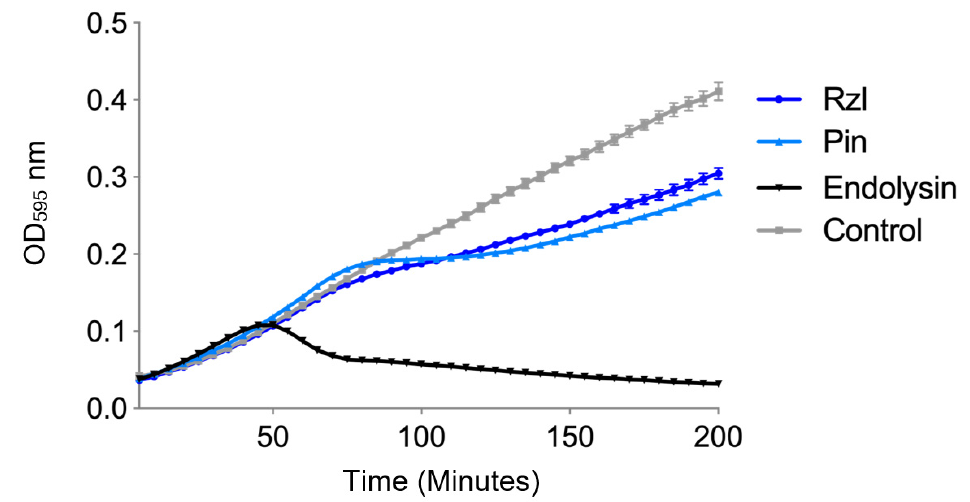
Figure 6. Complementation assay of lysis cassette proteins of φ NV3 by expression of constructs containing either the φ NV3 endolysin gene, pinholin and endolysin genes or the complete lysis cassette in BL21 AI E. coli following induction with 0.2% L-arabinose at T = 0. The control comprised of an uninduced BL21-AI containing the Pin + Endolysin construct. Mean values of 6 replicates are plotted, error bars = +/ − SEM.